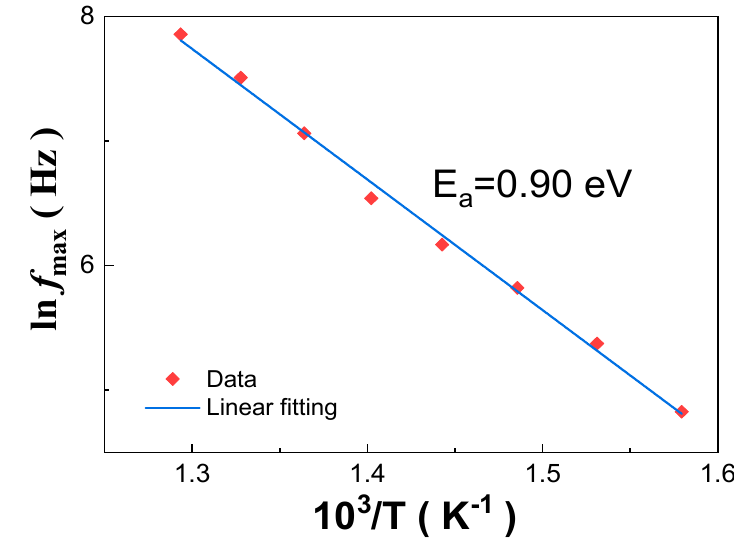
Figure 3. Linear fitting of relaxation frequency ( f max ) of the as-grown Mn:PIMNT single crystals according to the Arrhenius law. Table 2. The coefficient of determination ( Adj. R-Square ) for the fittings and activation energy ( E a ) for the relaxation processes of the as-grown and annealed Mn:PIMNT single crystals.